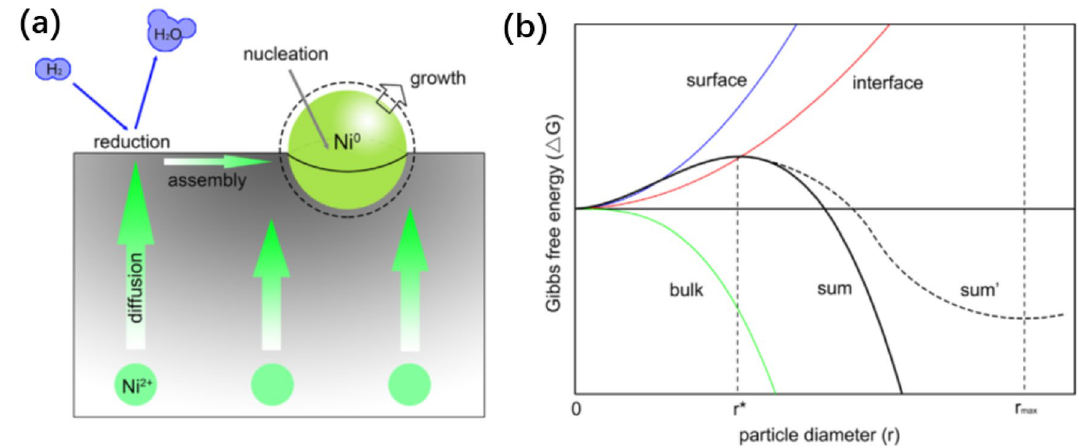
Fig. 6 a Illustration of the exsolution process, b Gibbs free energy change during the nucleation and growth. Reproduced with permission